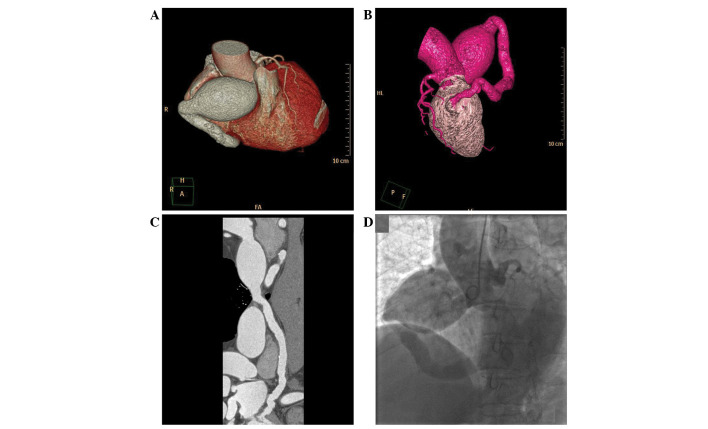
CAF originating from the RCA and draining into the LV in a 65-year-old female with heart failure. VR images show (A) a huge aneurysm in the proximal segment of the RCA and (B) a fistula vessel draining into the LV. (C) Curved multi-planar image shows a shunt from the RCA to the posterior wall of the LV. (D) CAG image shows communication between the RCA and the LV. CAF, coronary artery fistula; LV, left ventricle; RCA, right coronary artery; VR, volume rendered; CAG, coronary angiography.